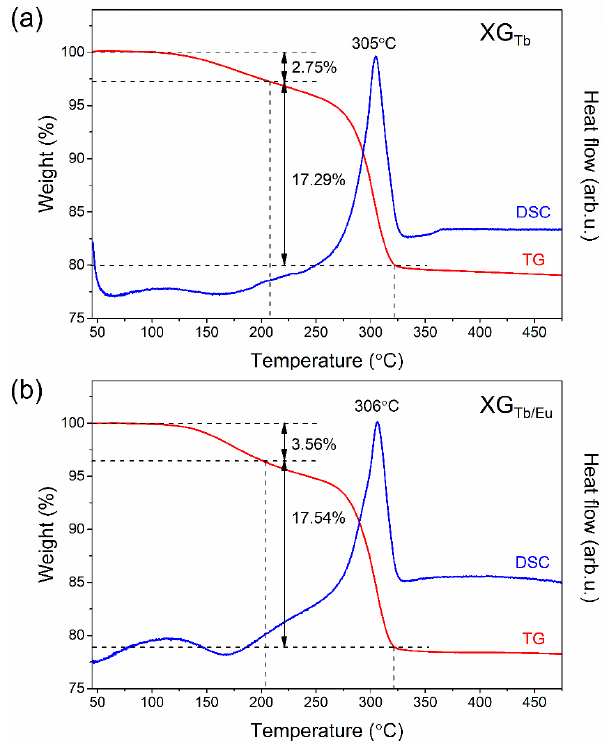
Figure 1. DSC and TG curves of prepared xerogels singly doped with Tb 3+ ( a ), and co-doped with Tb 3+ /Eu 3+ ions ( b ).